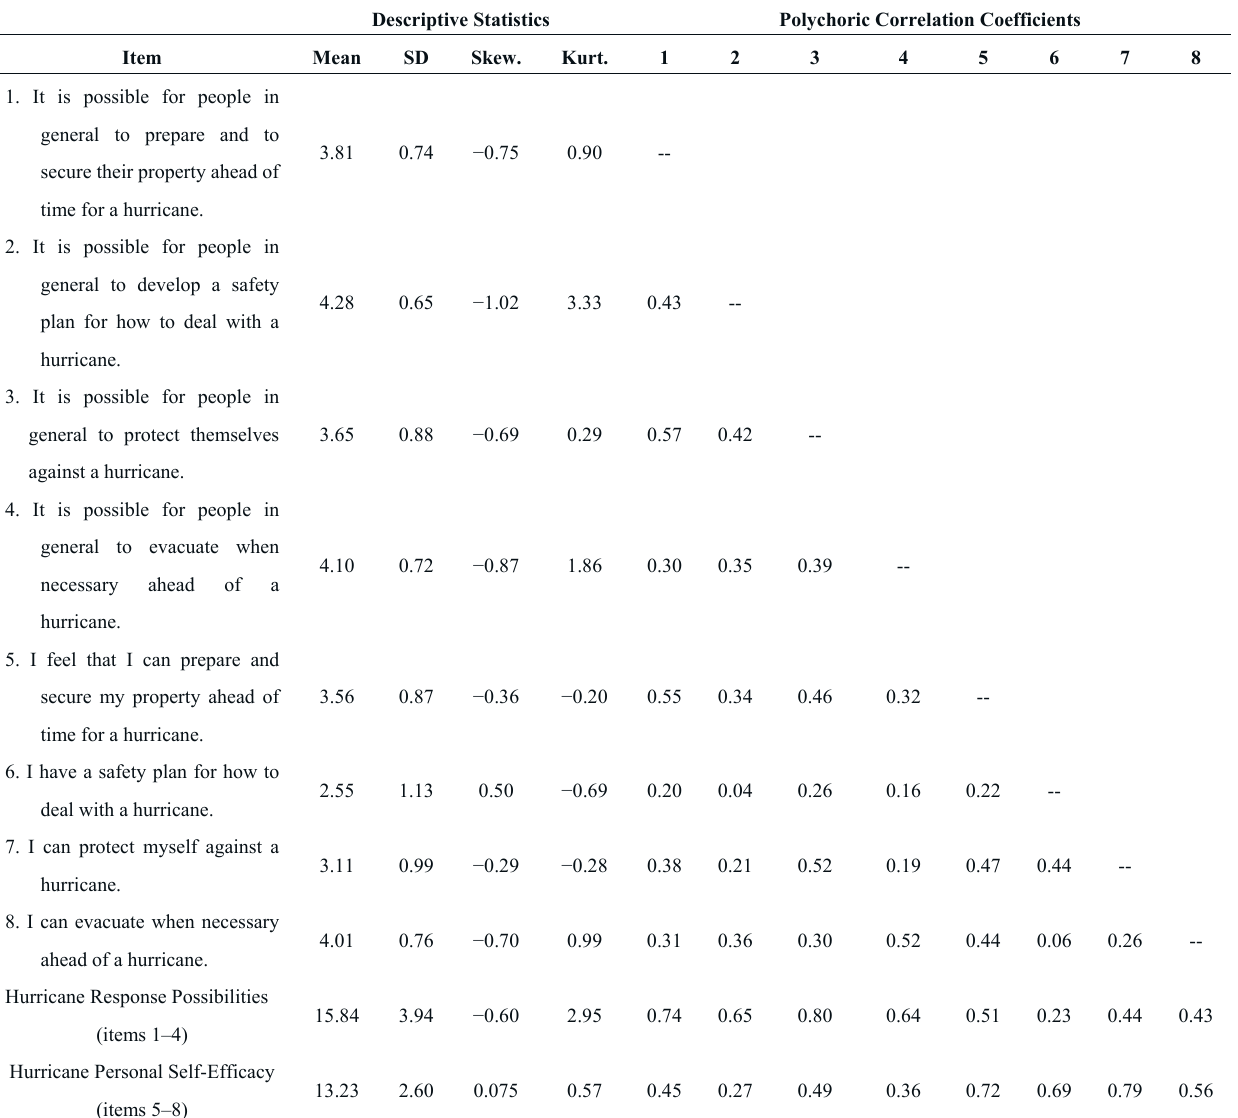
Table 2. Descriptive statistics and item correlations of the HPSES